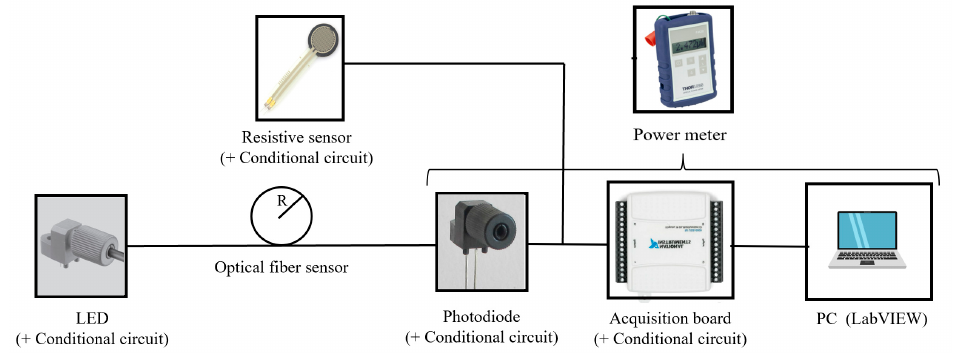
Figure 1. Schematic of the entire system for optical fiber sensor measurements.